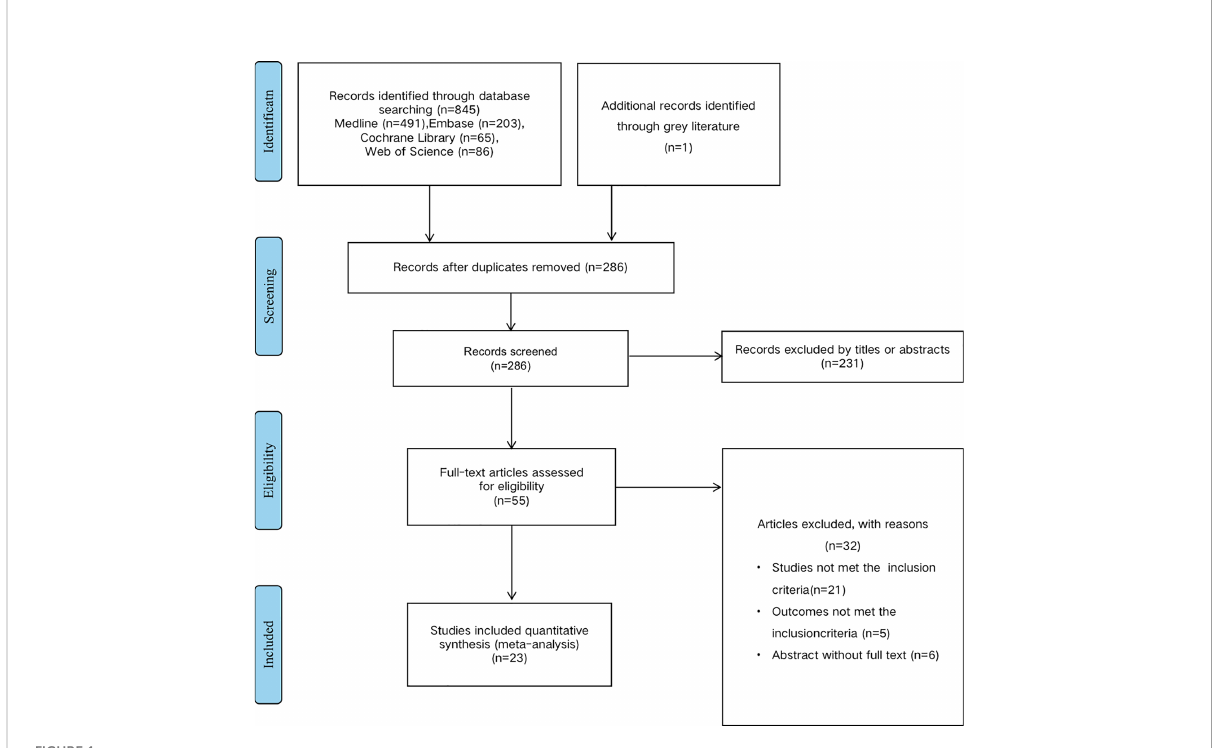
FIGURE 1 Methodological fl ow chart of the